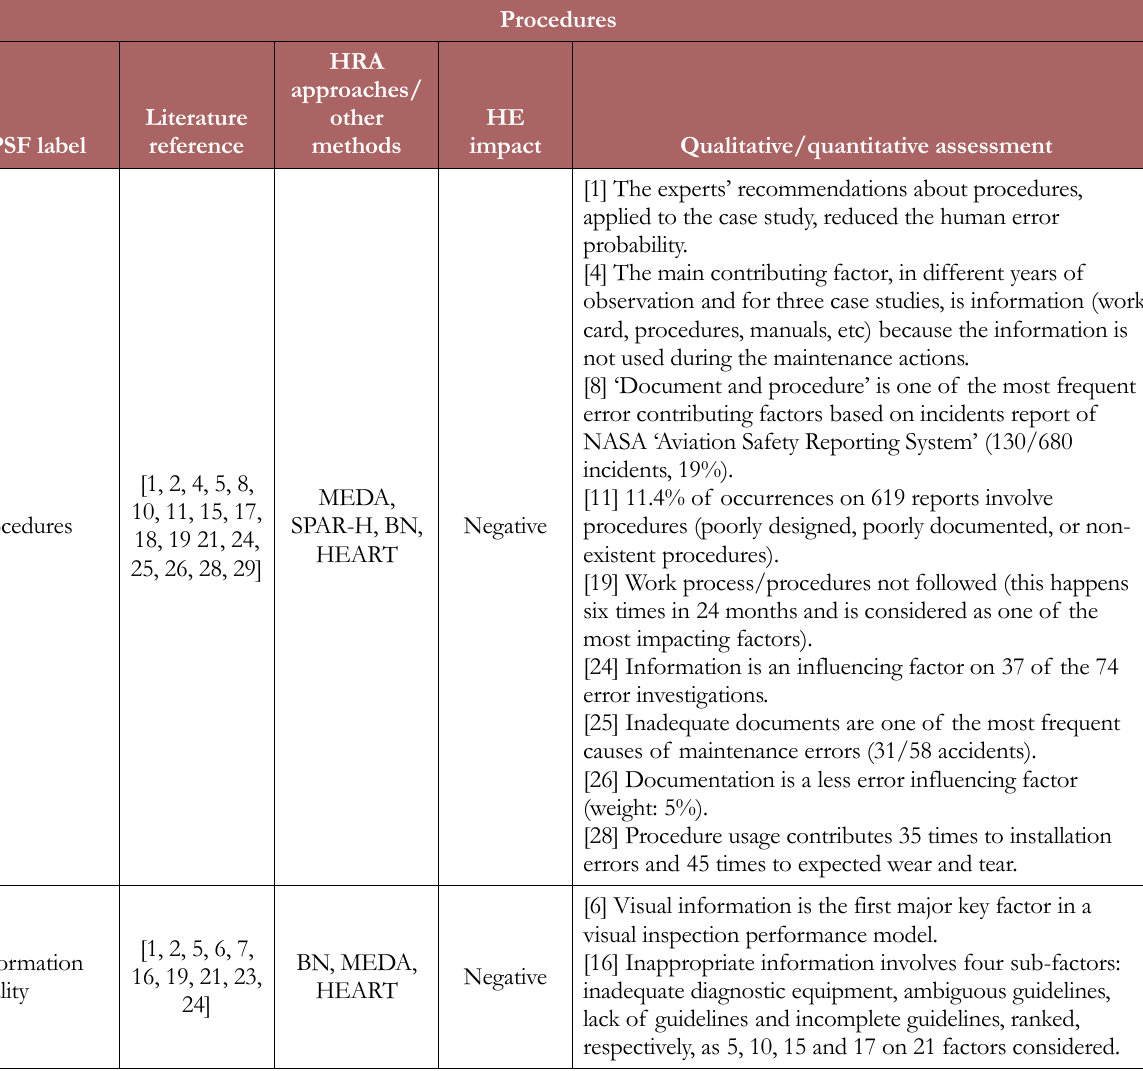
Table 4. Taxonomy of maintenance PSFs: procedures factor ‘Stress’ (Table 5), ‘work processes’ (Table 6) and ‘fitness for duty’ (Table 7) are relevant and they are composed of several PSF labels. Regarding ‘stress’ PSF, time pressure, circadian rhythm, environment, microclimate, lighting, noise and distraction/interruption were identified as the main PSFs. While the work environment depends on the specific context and could be less relevant, pressure time results in a significant contribution to the errors in maintenance activities. Instead, regarding ‘work processes’ PSF, the presence of maintenance teams makes their communication and coordination essential, and the presence of good leadership or supervision is crucial for the correct execution of maintenance processes. Finally, ‘fitness for duty’ PSF in maintenance involves different factor labels such as physical and mental fitness, illness, complacency and motivation. In particular, these last two factors critically influence the maintenance